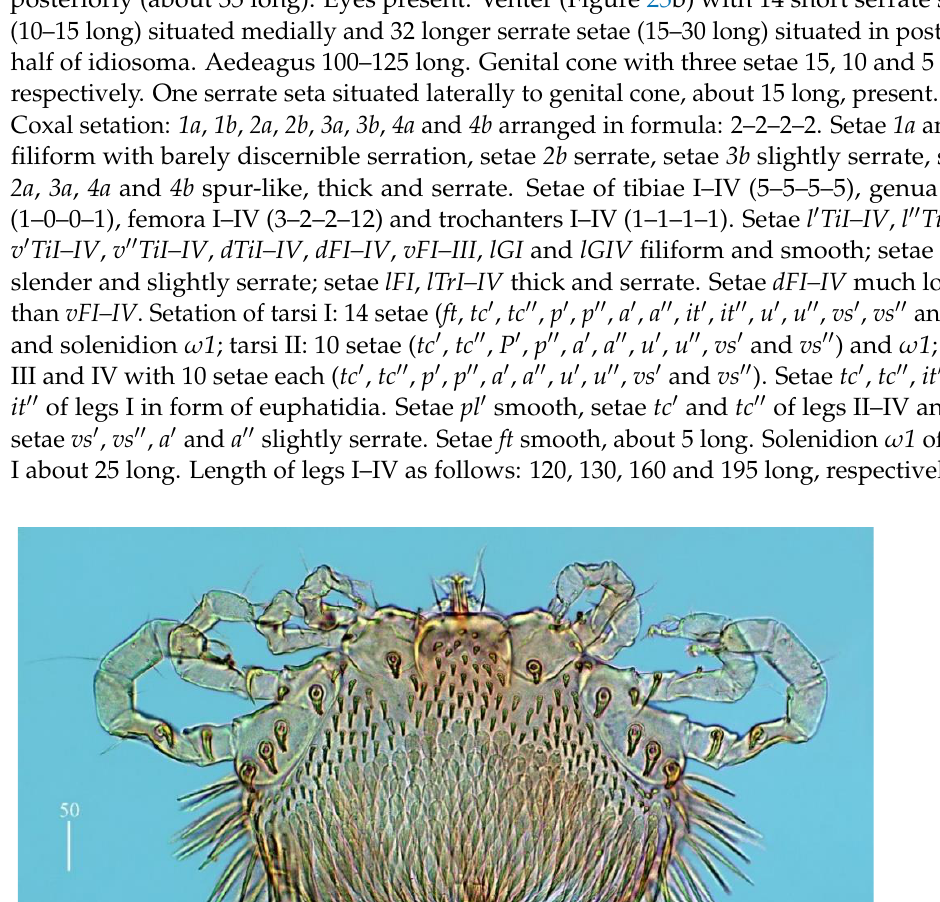
Figure 24. Geckobia phillipinensis Lawrence, 1953 female in ventral view.